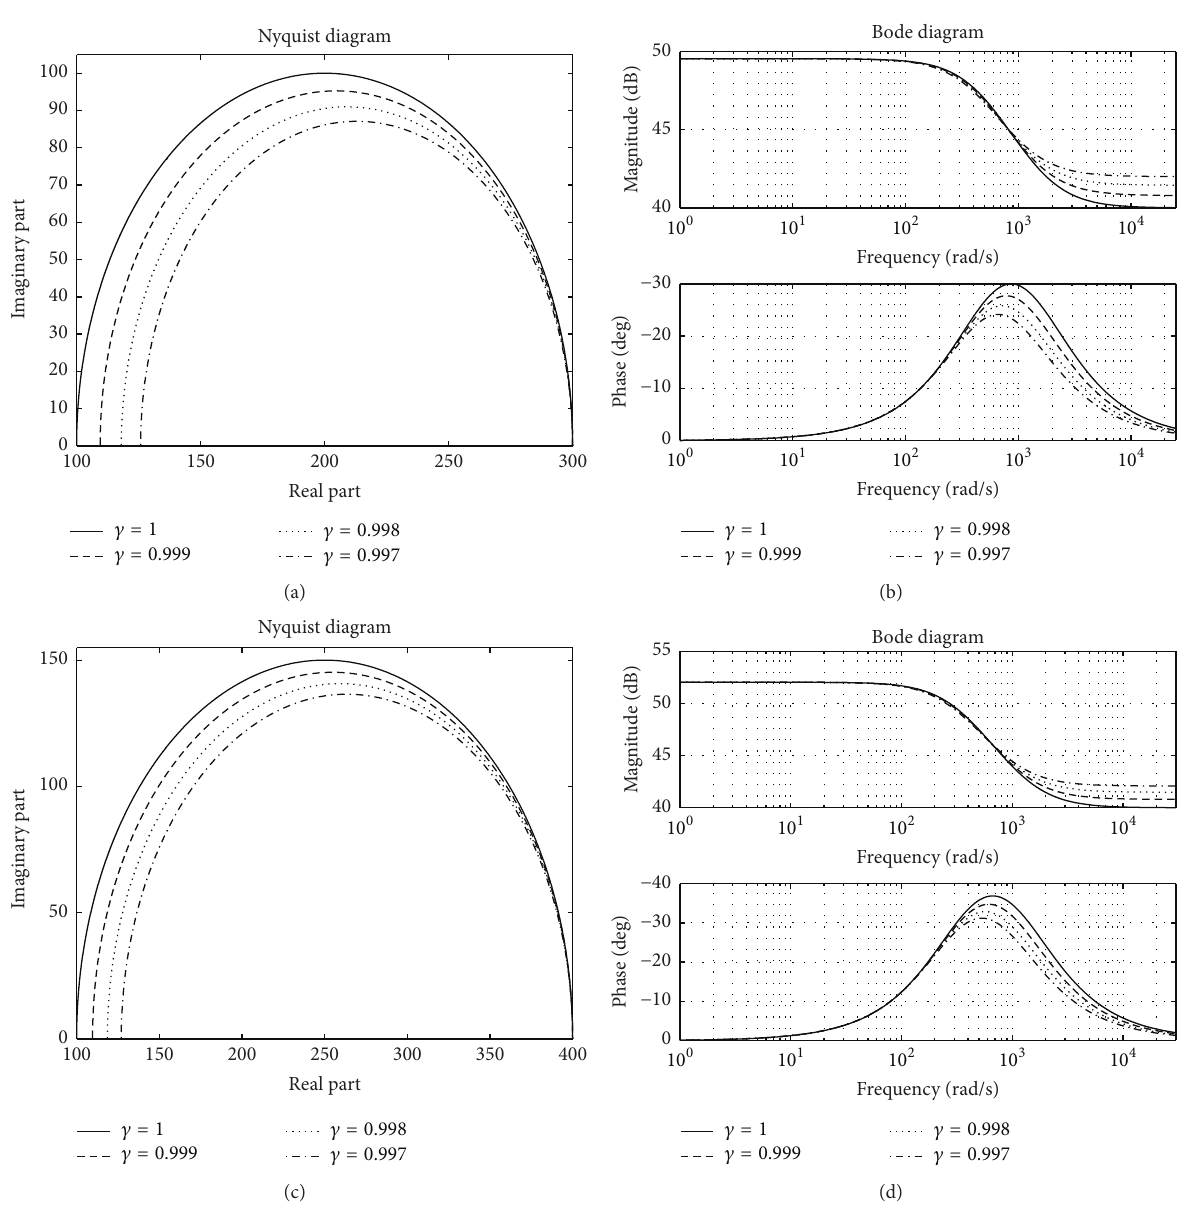
= 100 Ω , 𝐶 = 1 −4 F, and 𝑅 = 300 Ω , for 𝛾 = 1 , 𝑠 𝑝